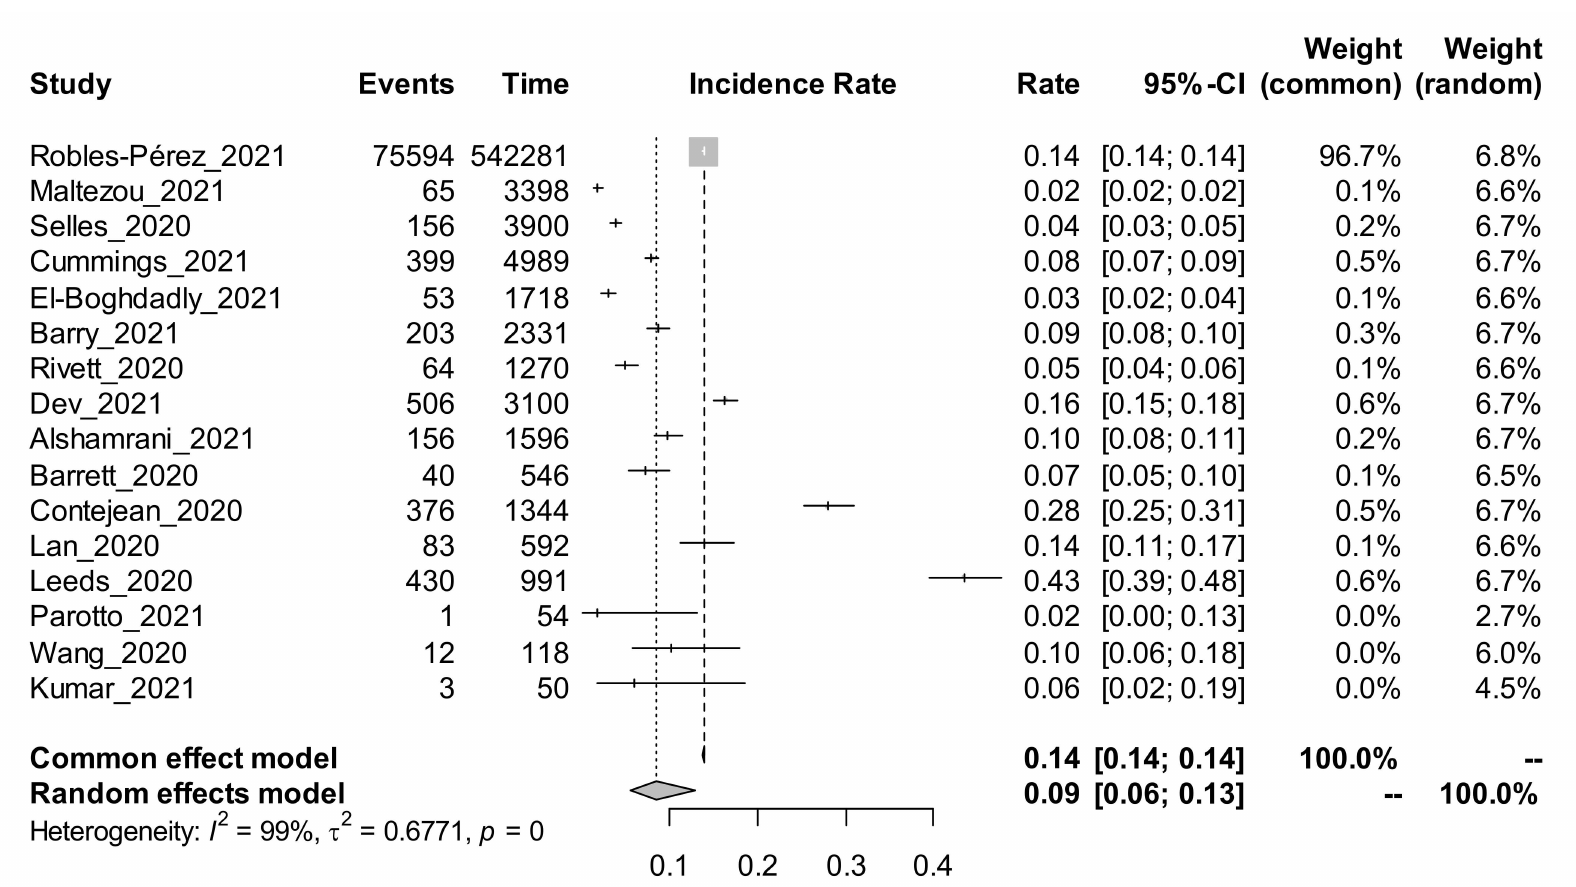
Figure 4. Forest plot showing the incidence rate of COVID-19 among studies using the PCR method of